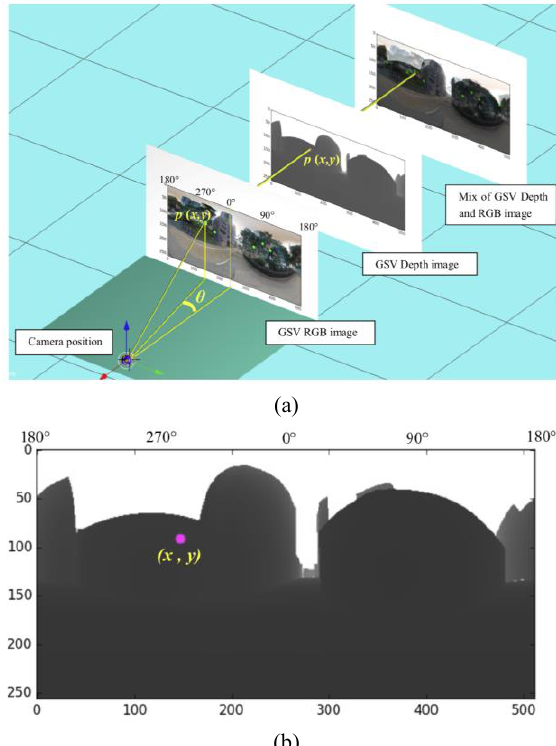
Figure 5. (a) Fusion of GSV Depth and RGB color images. The detected beam passes through a same pixel for GSV RGB and Depth images. (b) Depth image